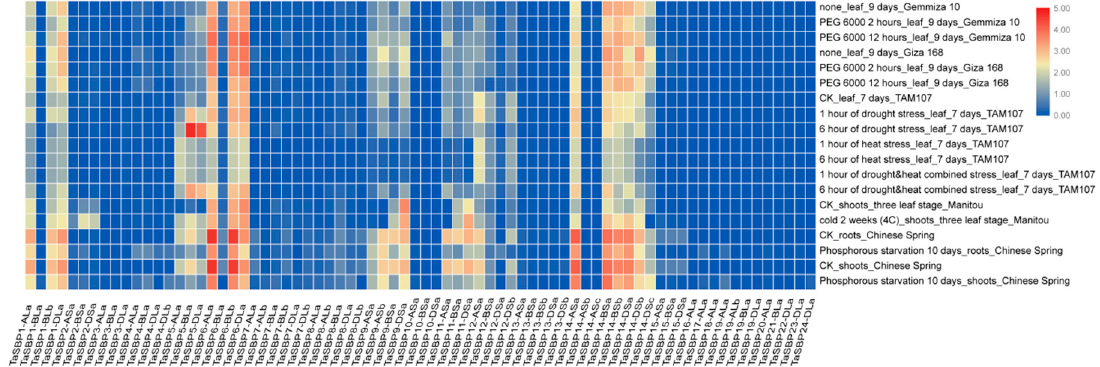
Figure 9. Expression patterns of TaSBP genes under di ff erent abiotic stress, including drought stress (cultivars: Gemmiza 10; Giza 168; TAM 107), heat stress (cultivar: TAM 107), drought and heat combined stress(cultivar: TAM107), coldstress(cultivar: Manitou), andphosphorousstarvation(cultivar: Chinese Spring) (SBA numbers: PRJNA257938, PRJNA253535, PRJNA306536 and PRJDB2496). Blocks with colors indicate decreased (blue) or increased (red) expression levels. The gradual change of the color indicates di ff erent level of gene log2-transformed expression (fold change > 3 is significantly